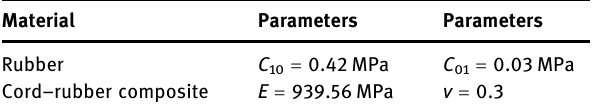
Table 1: Material parameters of bump Material Parameters